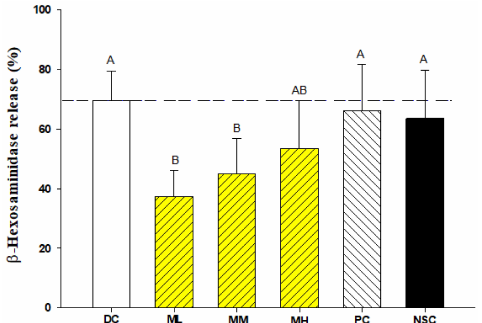
Figure 4. Effects of menthone inhalation with different doses on degranulation of lung mast cells of OVA/Al-sensitized and challenged BALB/c asthmatic mice. Values are means ± SD ( n = 6). Bars not sharing a common capital letter (A, B) are significantly different ( p < 0.05) from each other, assayed by one-way ANOVA, followed by Duncan’s multiple range test. The mouse lung mast cells were sensitized with compound 48/80 (30 µ g/mL). NSC: non-sensitized control; DC: dietary control; PC: positive control; ML: low dose menthone (0.3 mg/L); MM: medium dose menthone (1.2 mg/L); MH: high dose menthone (6